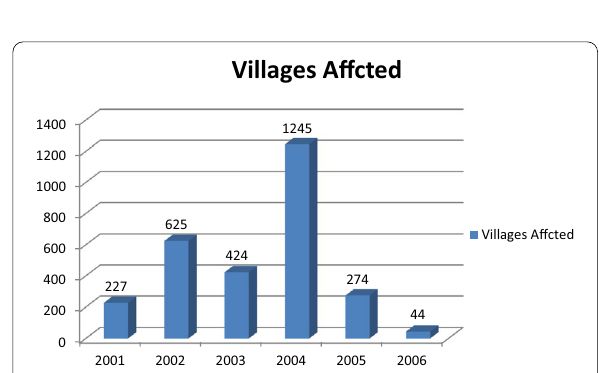
Fig. 3 Villages affected due to flodd and erosion is shown. Source: Water resource Department, GOA